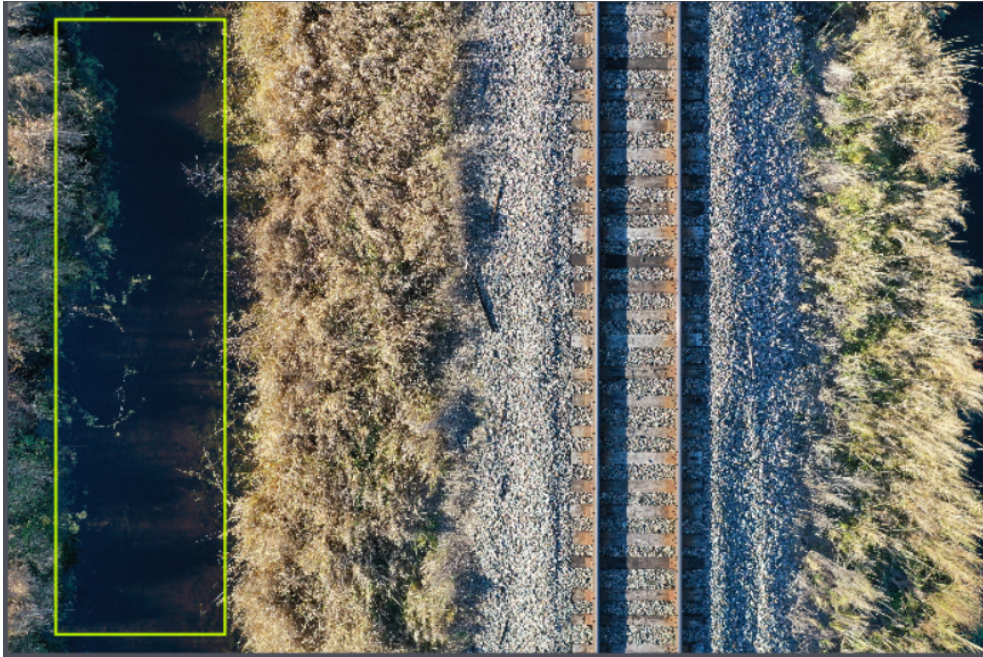
Figure 9. Example of water pooling.